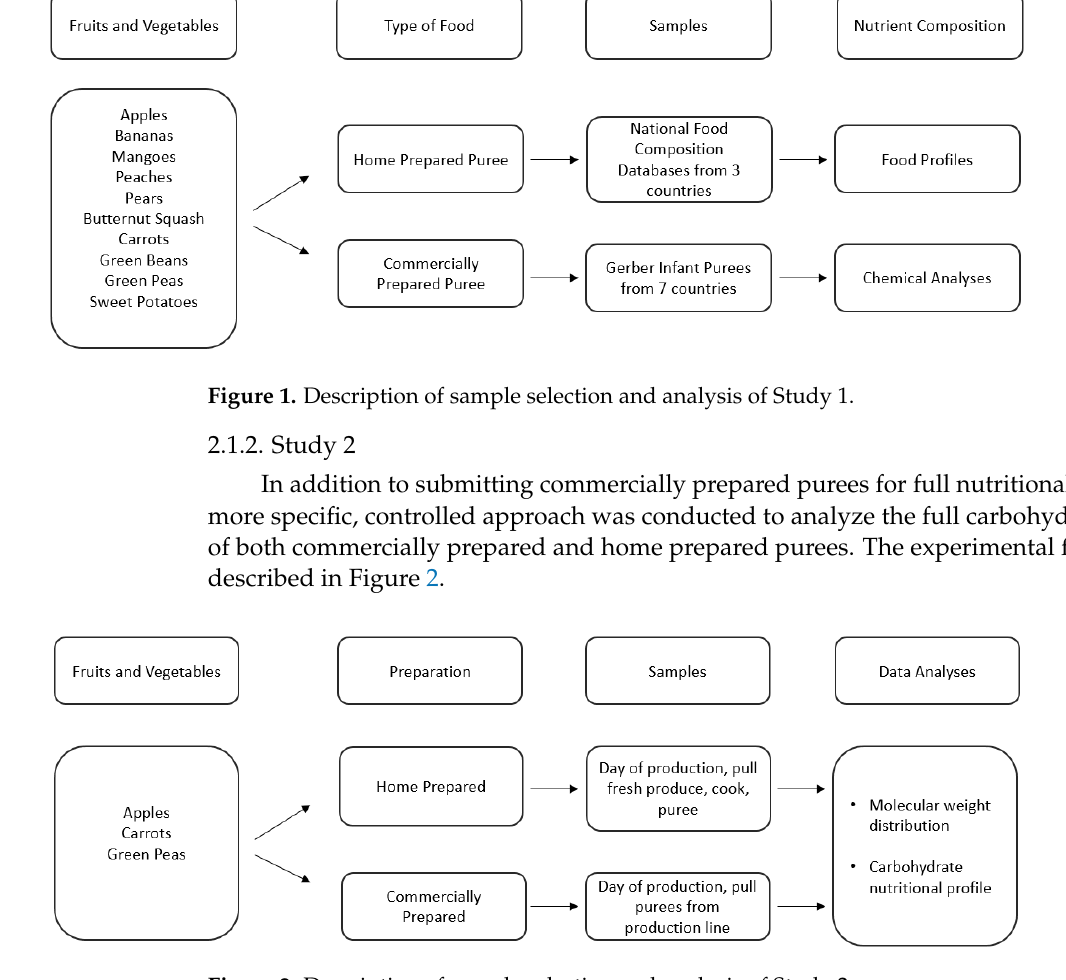
Figure 2. Description of sample selection and analysis of Study 2.